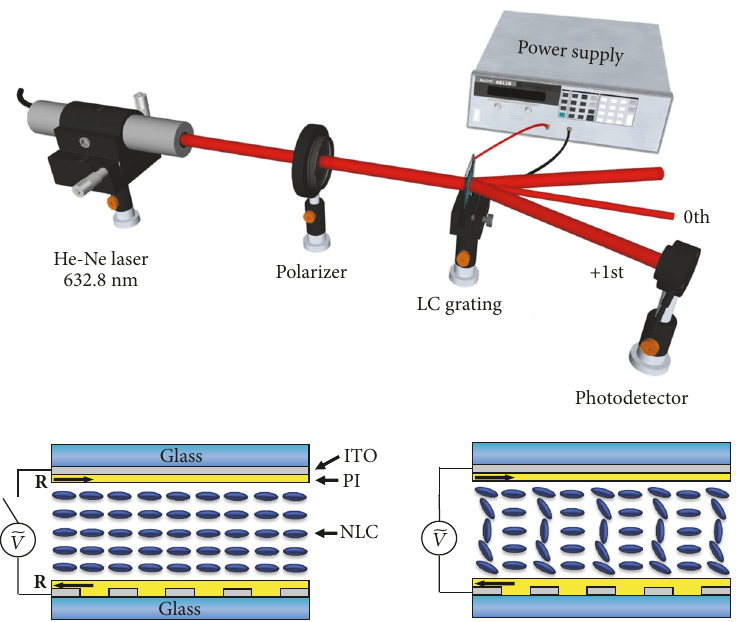
Figure 1: (a) Experimental setup for characterizing the performance of the phase grating. (b) The periodic distribution of refractive index of liquid crystals with an external 𝑎𝑐 voltage.